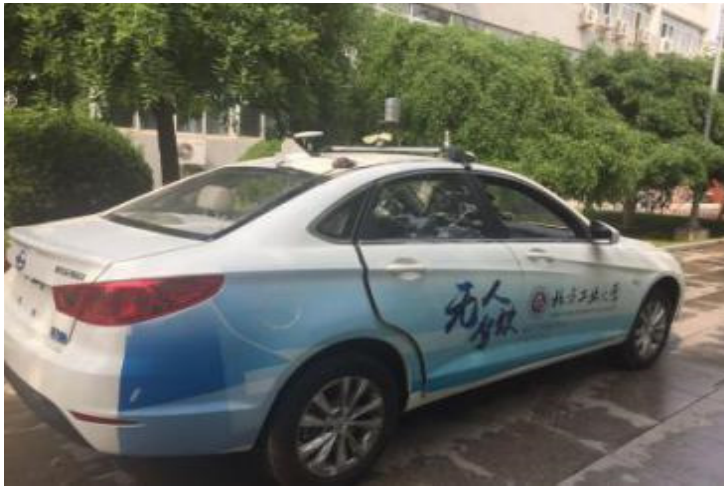
Figure 6. Unmanned vehicle platform with light detection and ranging (LiDAR).